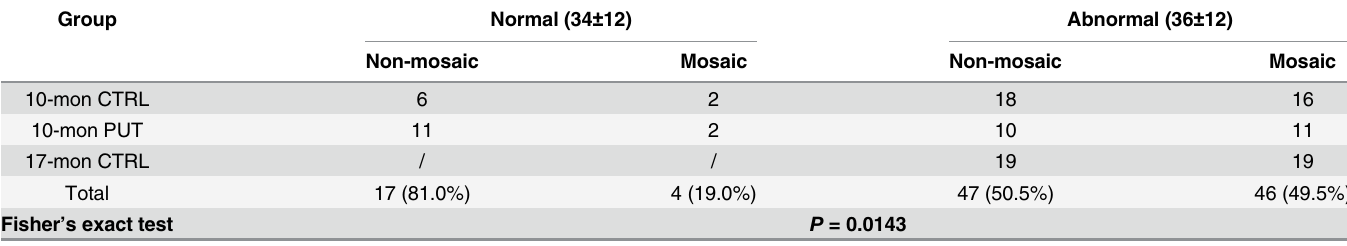
Table 3. Mosaicism amongst euploid normal and euploid abnormal embryos.